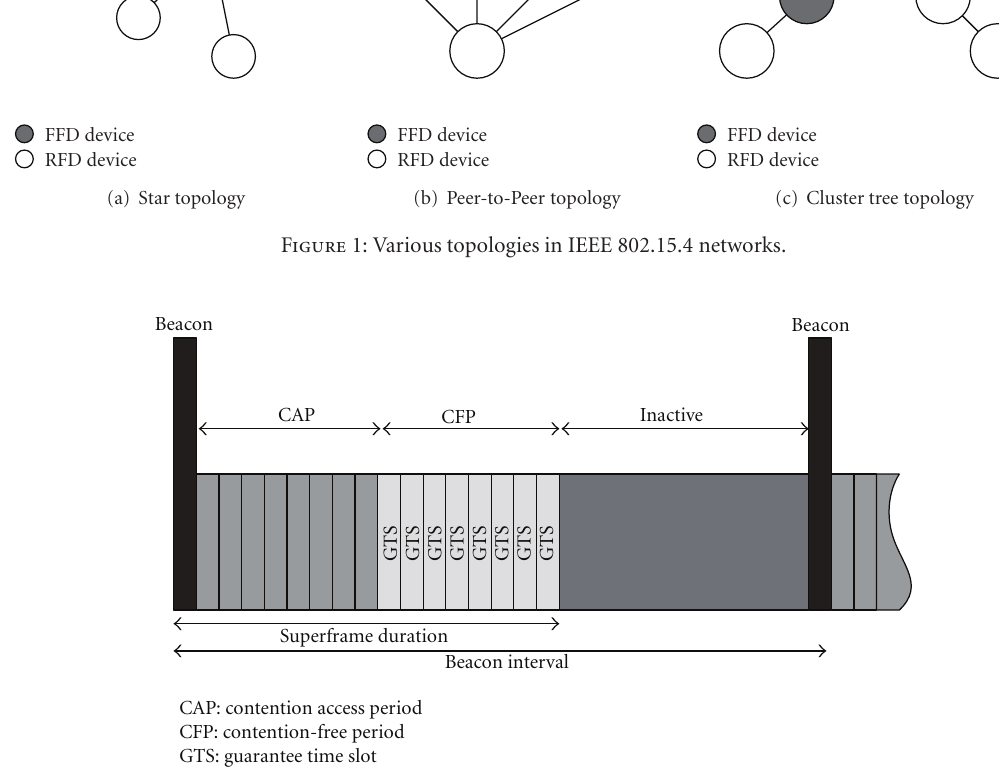
Figure 2: The superframe structure defined in IEEE